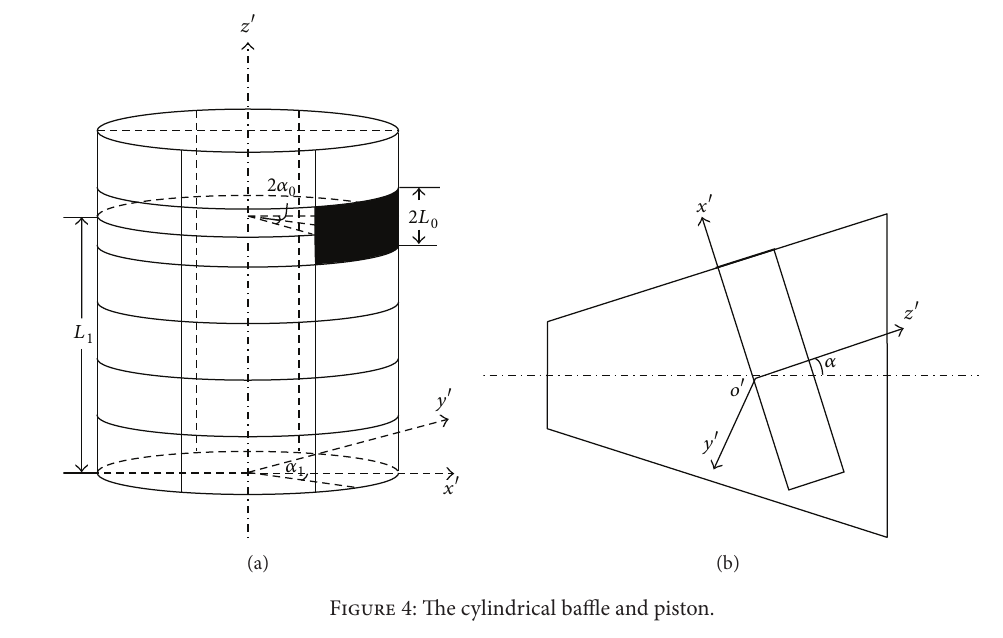
Figure 4: The cylindrical baffle and piston.